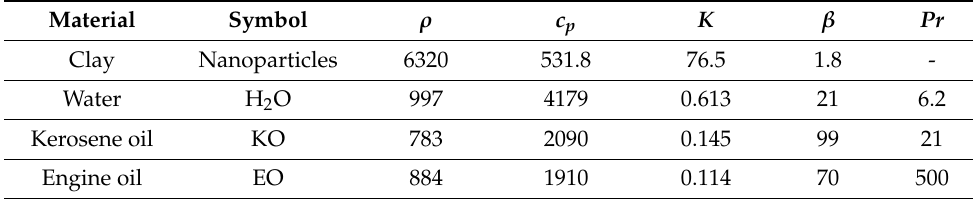
Table 1. Various material with different thermos-physio properties [30].